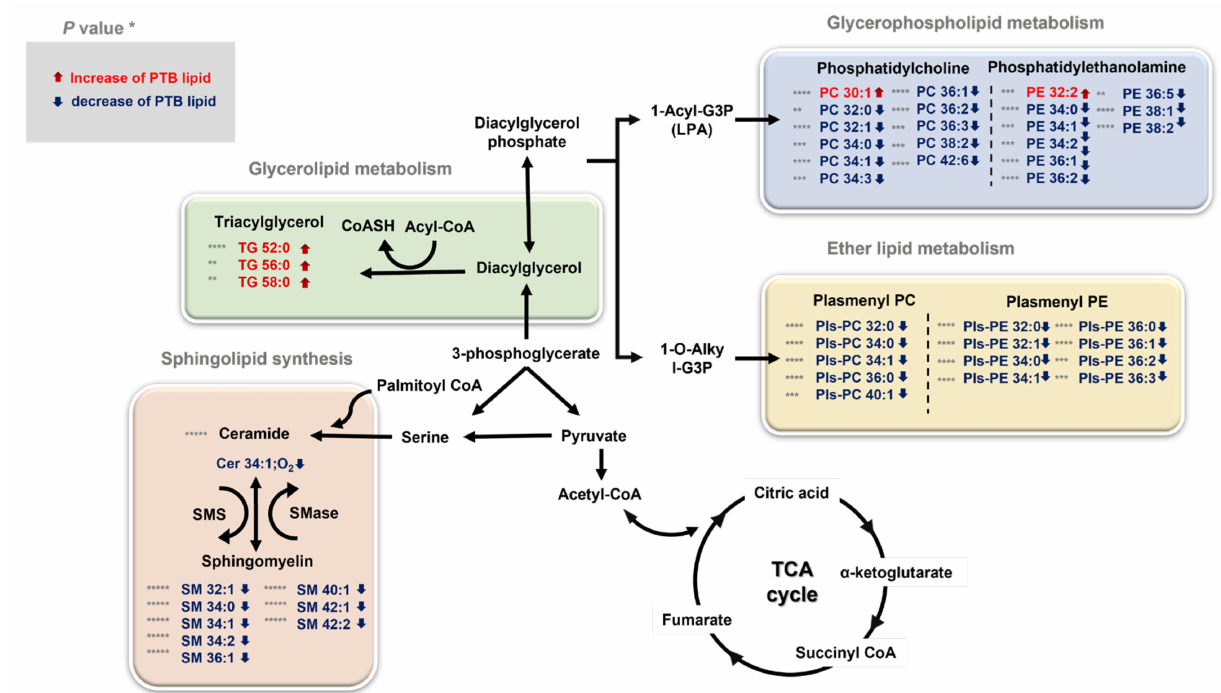
Figure 7. An overview of the integrated metabolic pathways altered by PTB and TB * p < 0.05, ** p < 0.01, *** p < 0.001, and **** p < 0.0001. The significantly changed lipids are indicated by arrows: ↓ downregulated and ↑ upregulated in PTBs. TG triglyceride, PC phosphatidyl- choline, PE phosphatidylethanolamine, PlsPC plasmenyl-phosphatidylcholine, PlsPE plasmenyl- phosphatidylethanolamine, SM sphingomyelin, Cer Ceramide, TCA cycle tricarboxylic acid cycle, SMS sphingomyelin synthase, SMase sphingomyelin